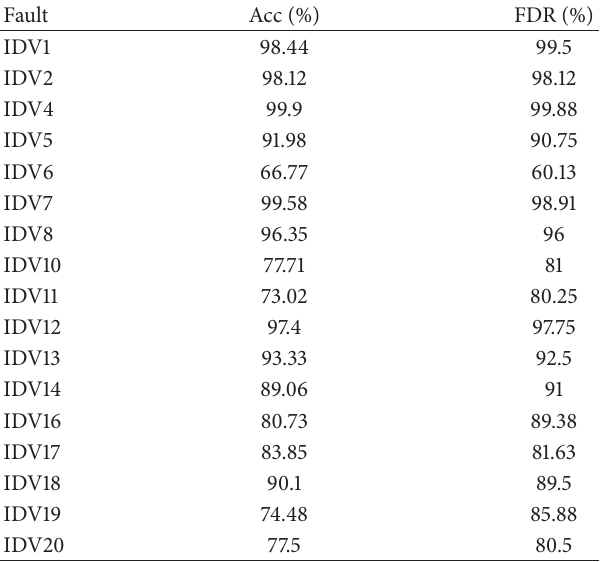
Table 3: Results of faults detection with one against one classifier.